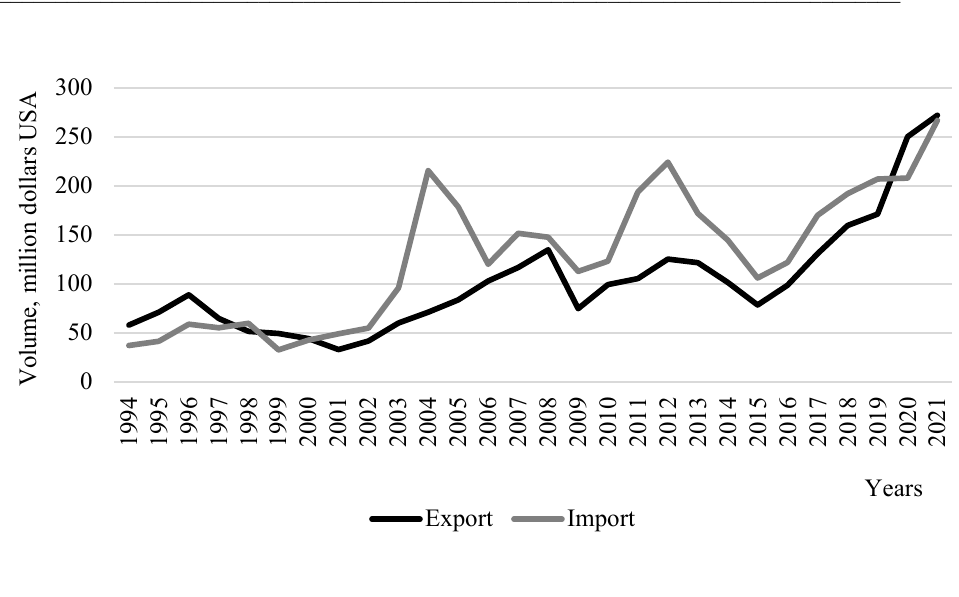
Fig. 5. International merchandise trade between Latvia and Ukraine: export and import of goods in 1994–2021 (United Nations,